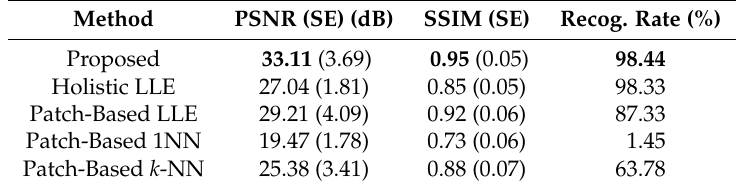
Table 1. Comparison of the proposed method with the holistic method and various